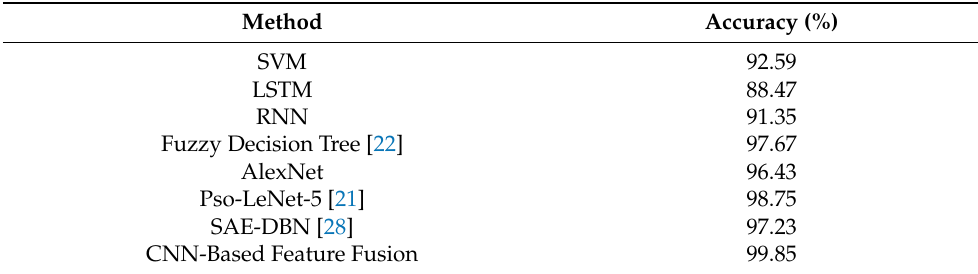
Table 8. Comprehensive comparison of classification